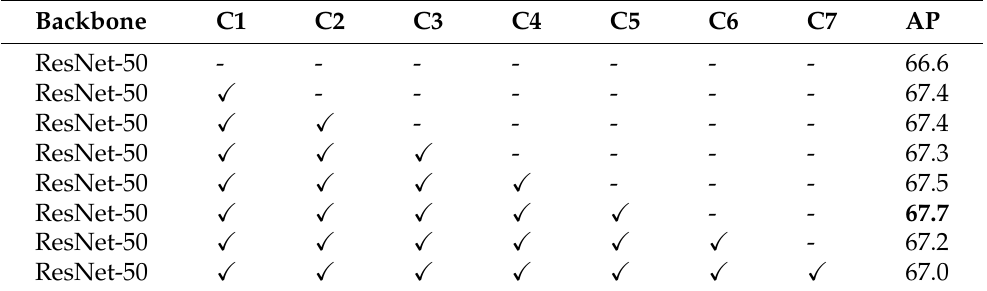
Table 3. The performance of applying filtered convolutions to different network layers.